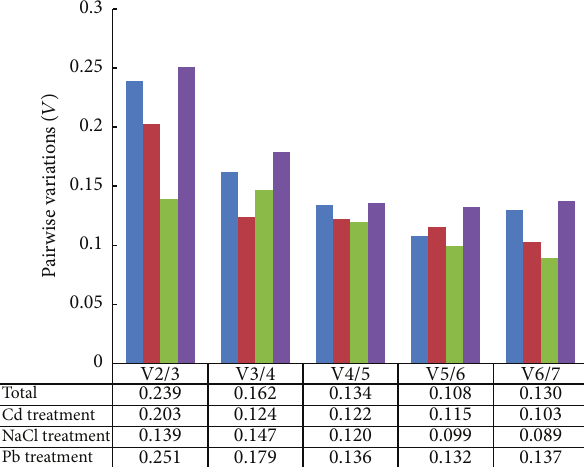
Figure 3: Determination of the optimal number of reference genes by GeNorm